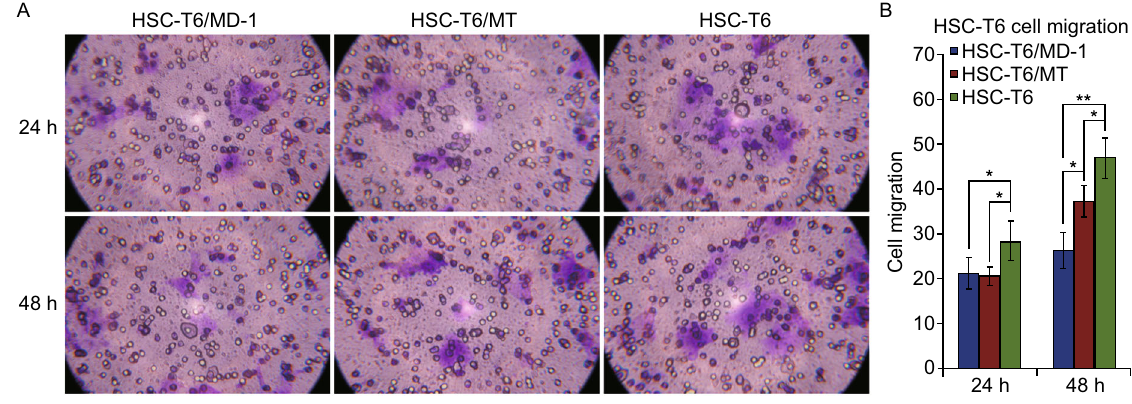
Figure 2. Inhibitory effects of MD-1 on the motility of HSC-T6 cells. (A) Top: Representative picture to show the migration ability of HSC-T6 cells at the same cell viability (50%) after 24 h of drug action (MD-1, MT, and control). Bottom: After 48 h of drug action. (B) Statistics for the migration ability of HSC-T6 cells. * P < 0.05; ** P < 0.01.